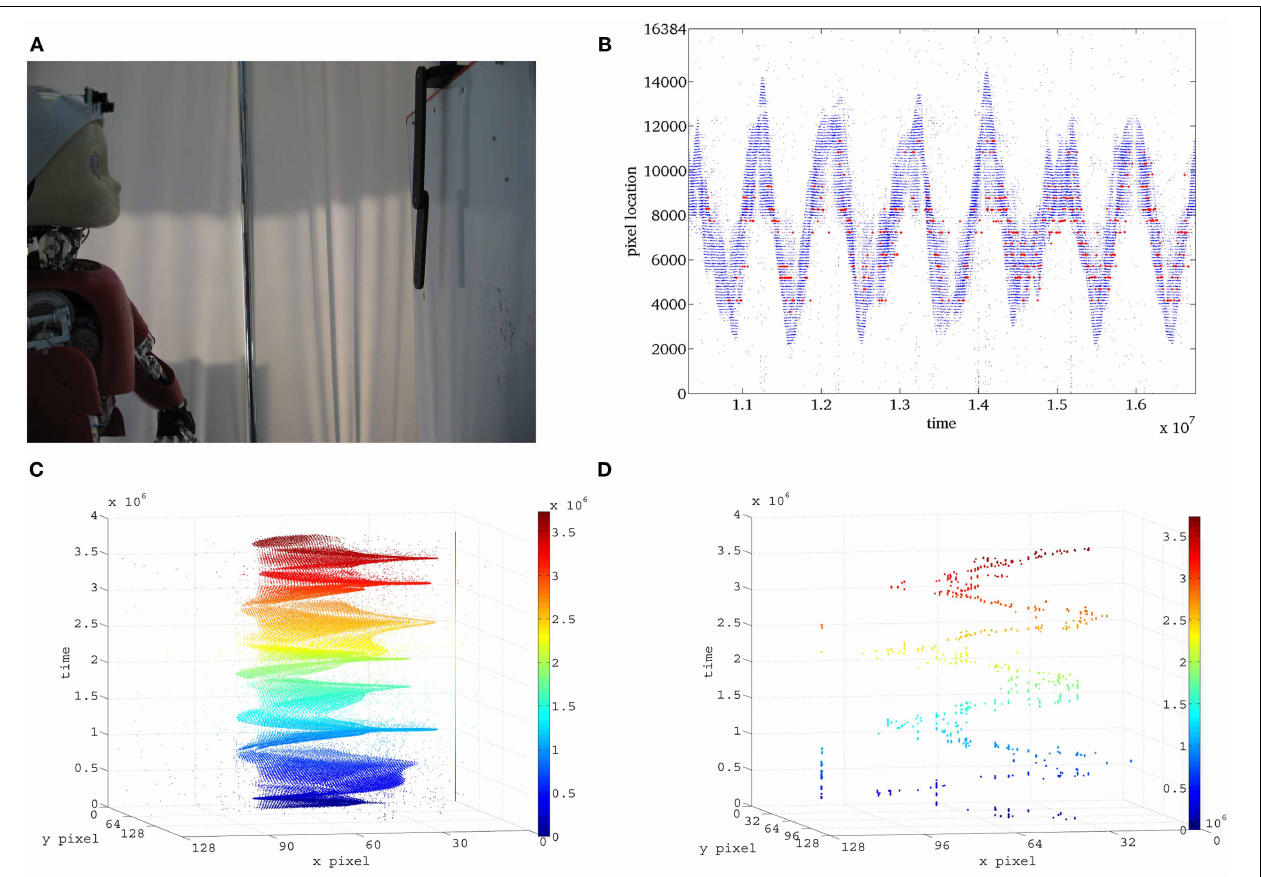
FIGURE 4 | Second scenario. (A) The chaotic pendulum is located 50 cm far from the robot to keep the whole stimulus in the camera’s field of view. In the setup, DVS sensors are embedded in the iCub’s eyes to exploit ocular movements, while the Dragonfly cameras are mounted